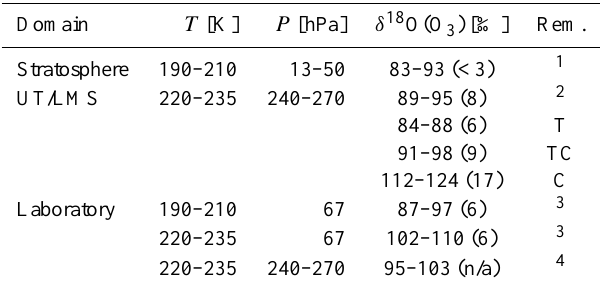
Table 1. Ozone 18 O/ 16 O isotope ratios from literature and this study.